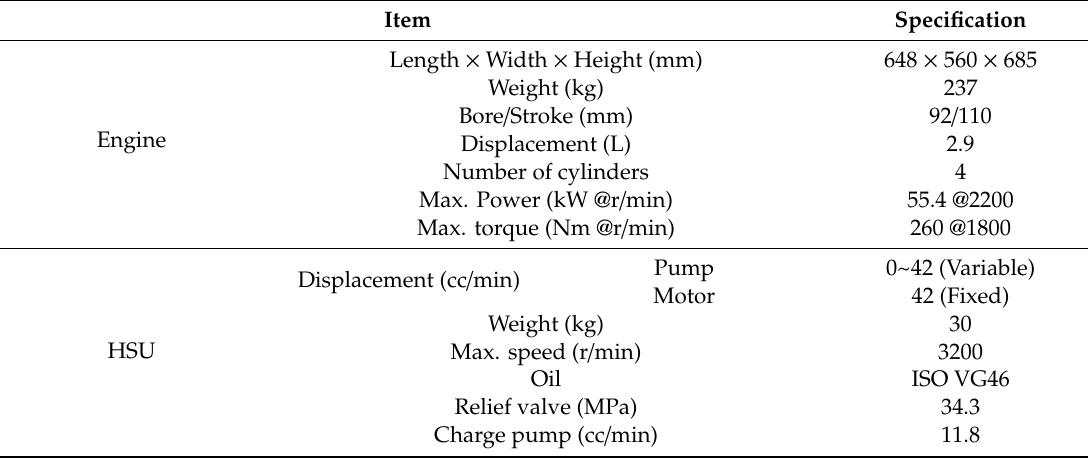
Figure 2. Layout of the HSU of the HMT prototype tractor used in this study